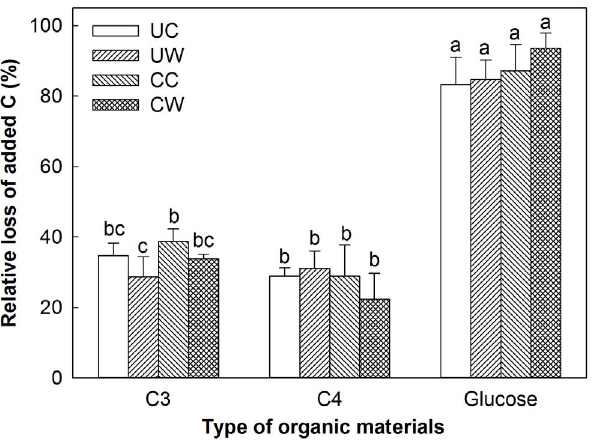
Figure 4. Warming- and clipping-induced relative loss of added C (i.e., glucose, C 3 and C 4 plants) compared to no additional substrate on soil respiratory C release (i.e., percent changes in soil respiratory C release between added C and no added substrate) under the four treatments. UC: unclipped control; UW: unclipped and warmed; CC: clipped and control; CW: clipped and warmed. Vertical bars and their error bars represent means and standard errors ( n 5 4). The different letters indicate statistical